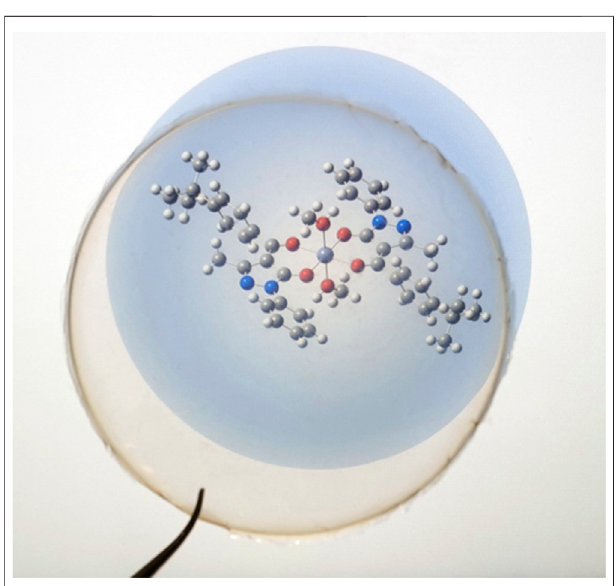
FIGURE 6 | Photograph of the CS@Zn 10% fi lm on the molecular structure of the [Zn(Q PhtBu ) 2 (MeOH) 2 ]